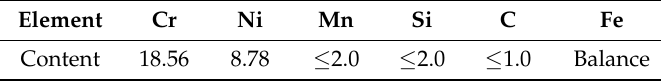
Table 1. Chemical compositions of 304 stainless steel (wt.